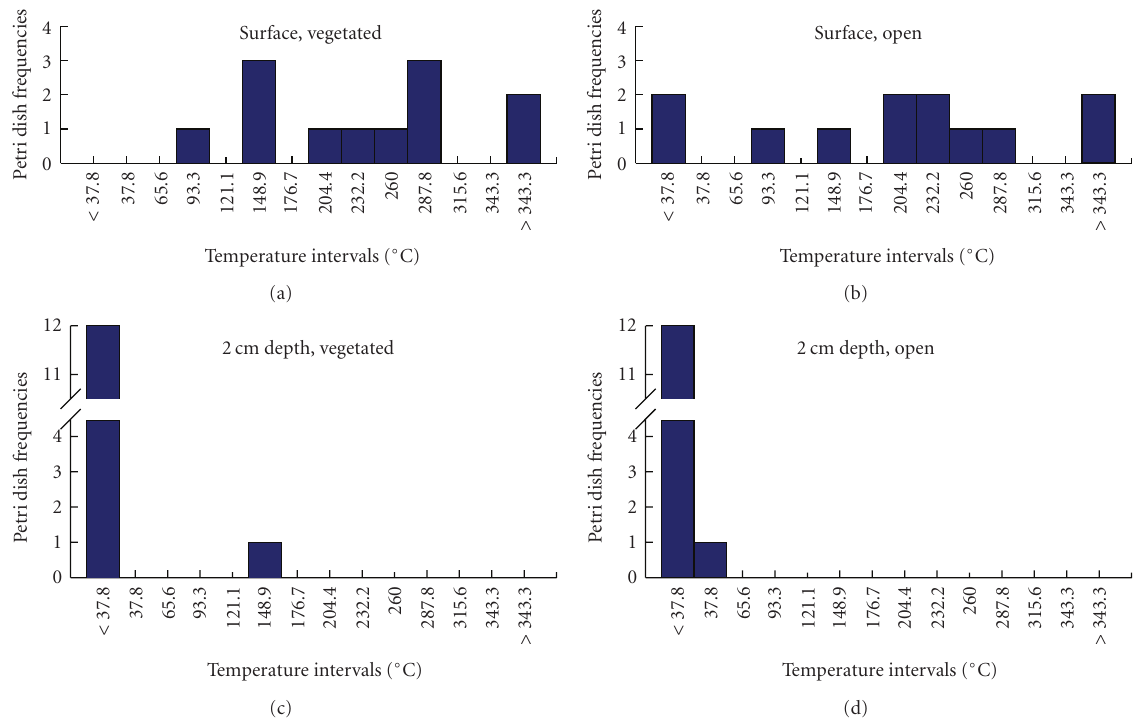
Figure 5: Frequency distributions of maximum petri dish temperatures during a prescribed sand pine scrub fire at Archbold Biological Station, Florida on May 25, 1993. Temperatures were quantified with temperature-sensitive paints on the petri dishes; temperature intervals for the frequency distributions represent melting points of the paints. Petri dishes were placed at the soil surface in vegetated (a) and open (b) microsites, and at 2cm depth in vegetated (c) and open (d) microsites; each depth-microsite combination was replicated 12 times.